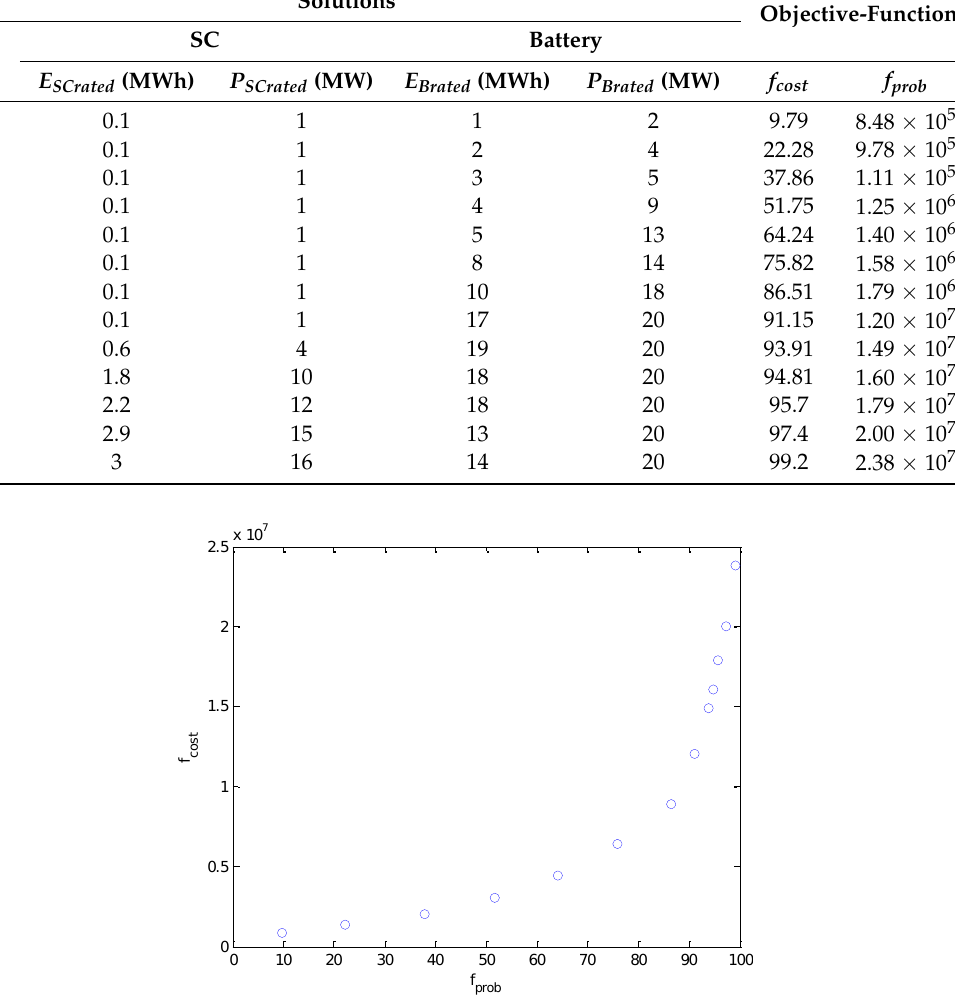
Figure 5. Distribution of optimal solutions in the objective space.